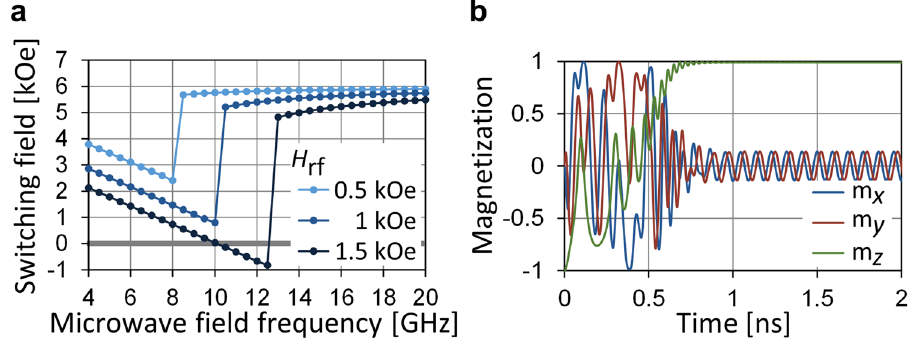
Figure 7. ( a ) H versus f obtained by macrospin simulation. ( b ) Time evolution of x -, y -, and z -components sw rf of the magnetization direction for =